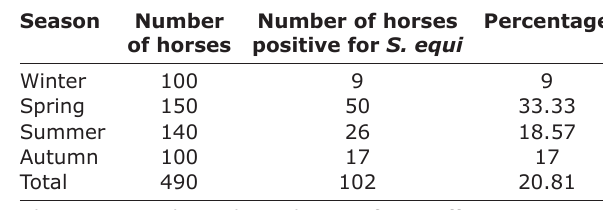
Table-2: Prevalence of strangles among Arabian horses in different seasons of the year.